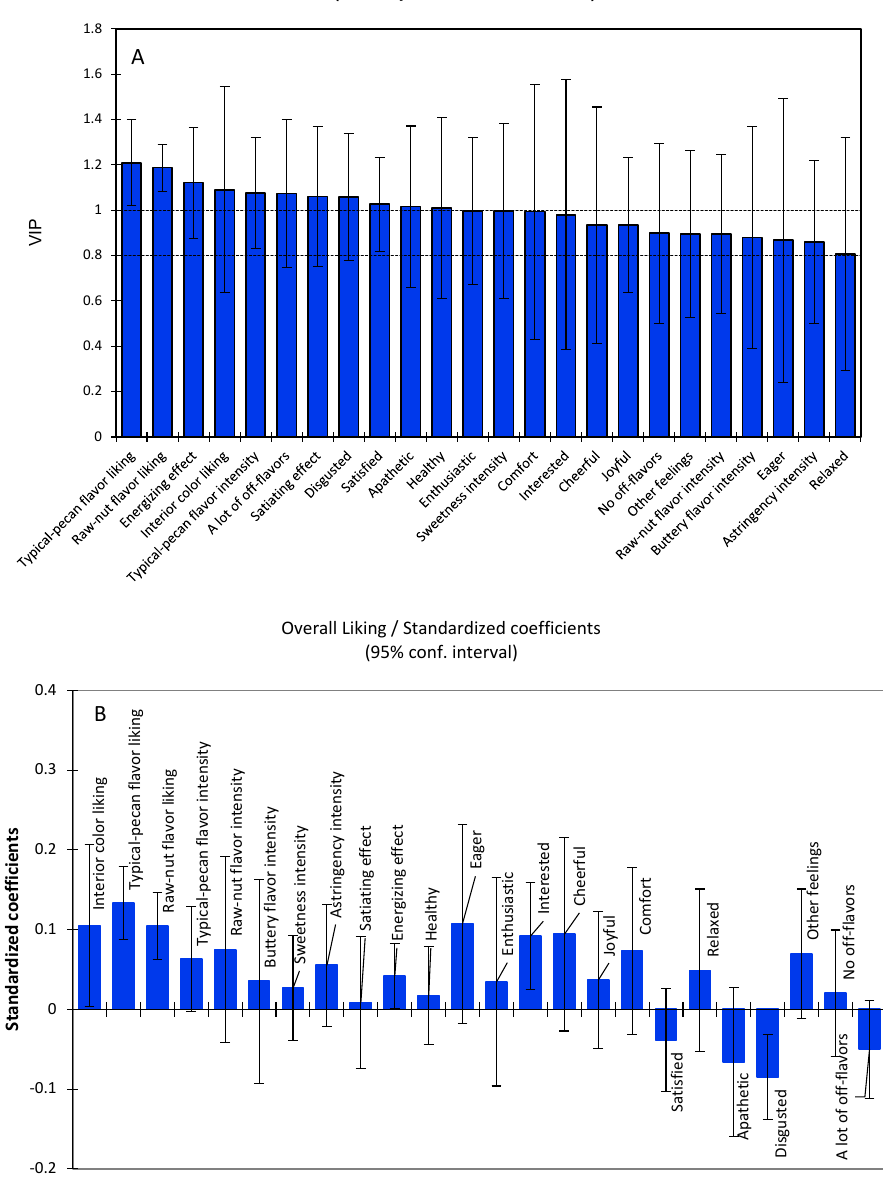
Figure 5. Partial least square (PLS) regression for the associations of overall acceptance and all remaining attribute likings, intensities, off-flavors, and emotional responses with variable importance in projection (VIP) > 0.8 for 14 pecan kernel samples, including ( A ) selected variables with VIPs > 0.8, and ( B ) standardized coefficients of each attribute used to predict overall acceptance. Prediction parameters were R 2 = 0.997, Q 2 cum = 0.979, and RMSE = 0.027, indicating a good fit model.